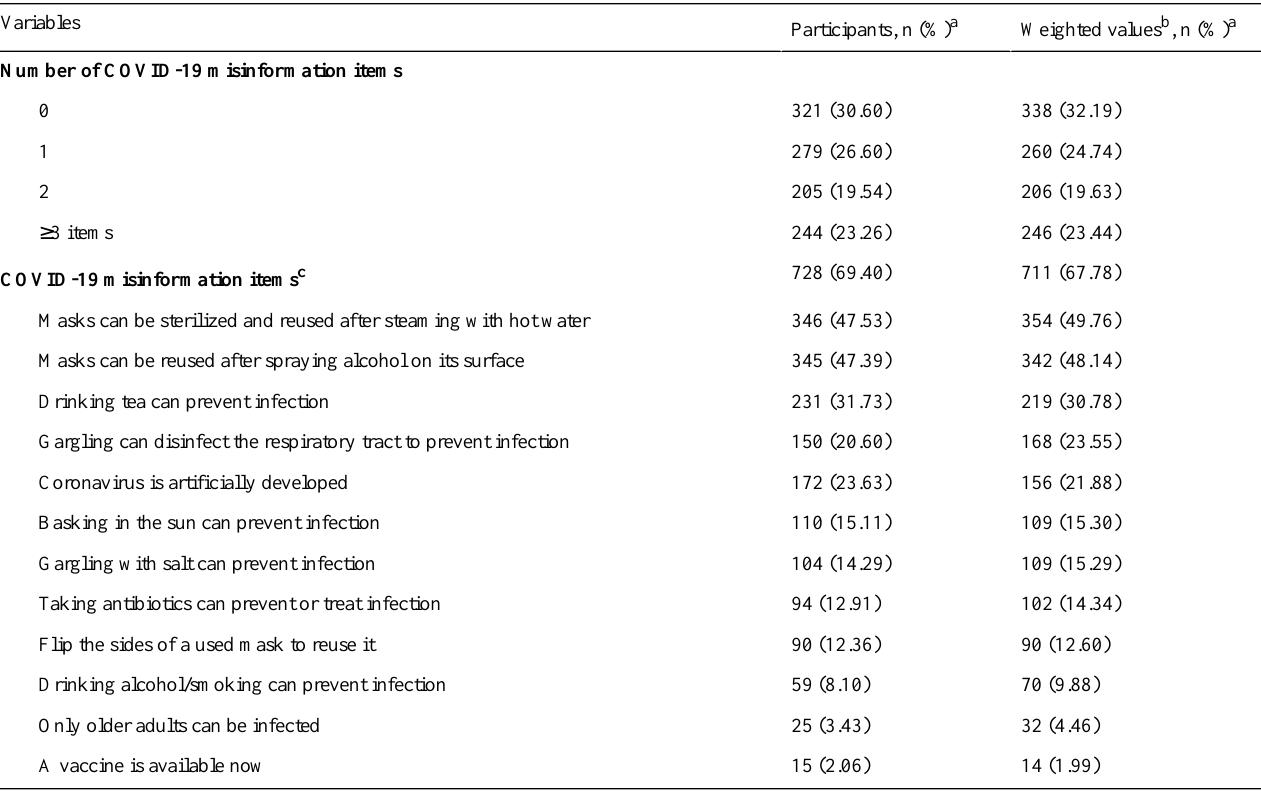
Table 2. Respondents’exposure to COVID-19 misinformation